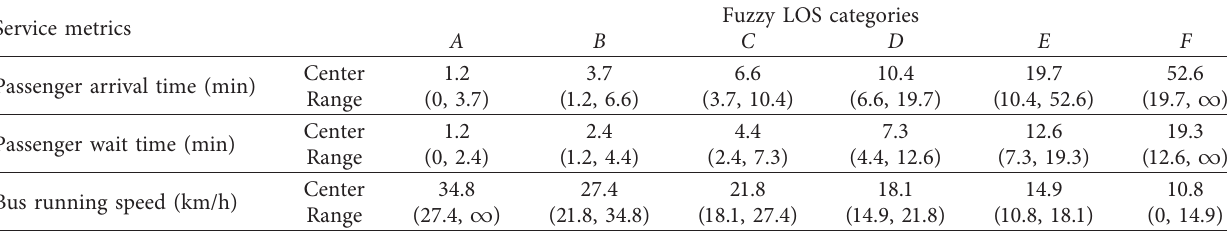
Table 4: BRT fuzzy LOS criteria for the anxious passenger group (ranges and centers of service metrics for fuzzy LOS categories). Service metrics